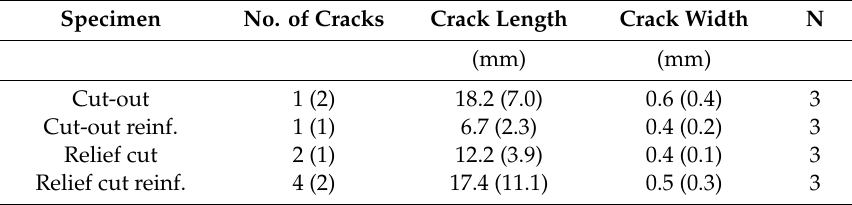
Table 1. Number of cracks and crack geometry after bending (SD in brackets). Specimen